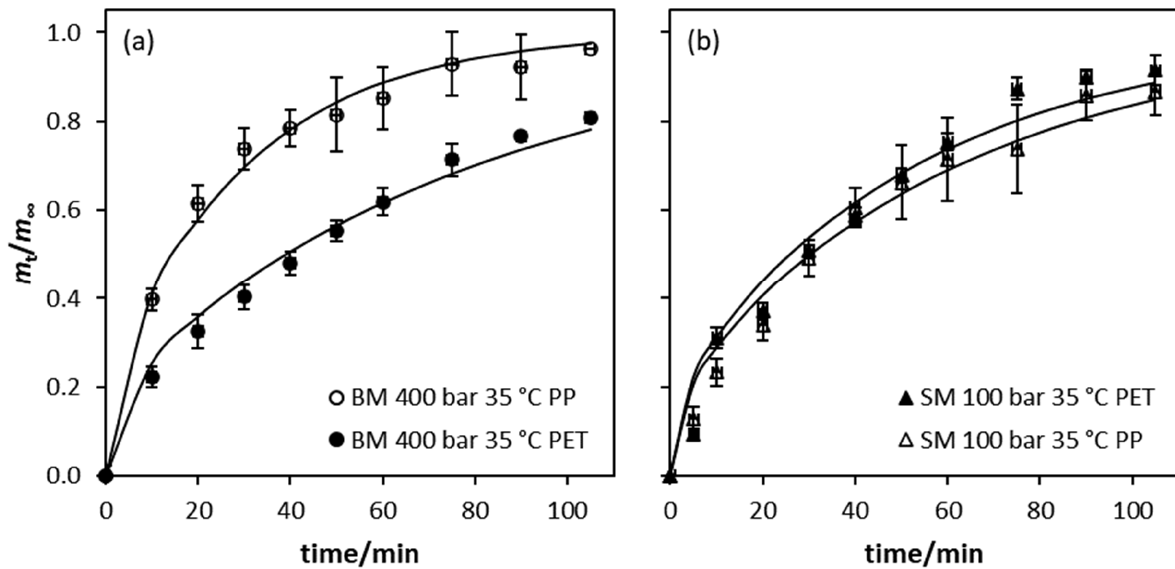
Figure 5. OLE diffusion of samples impregnated at 400 bar 35 °C using BM ( a ) and 100 bar 35 °C using SM ( b ) according to Fick’s law.